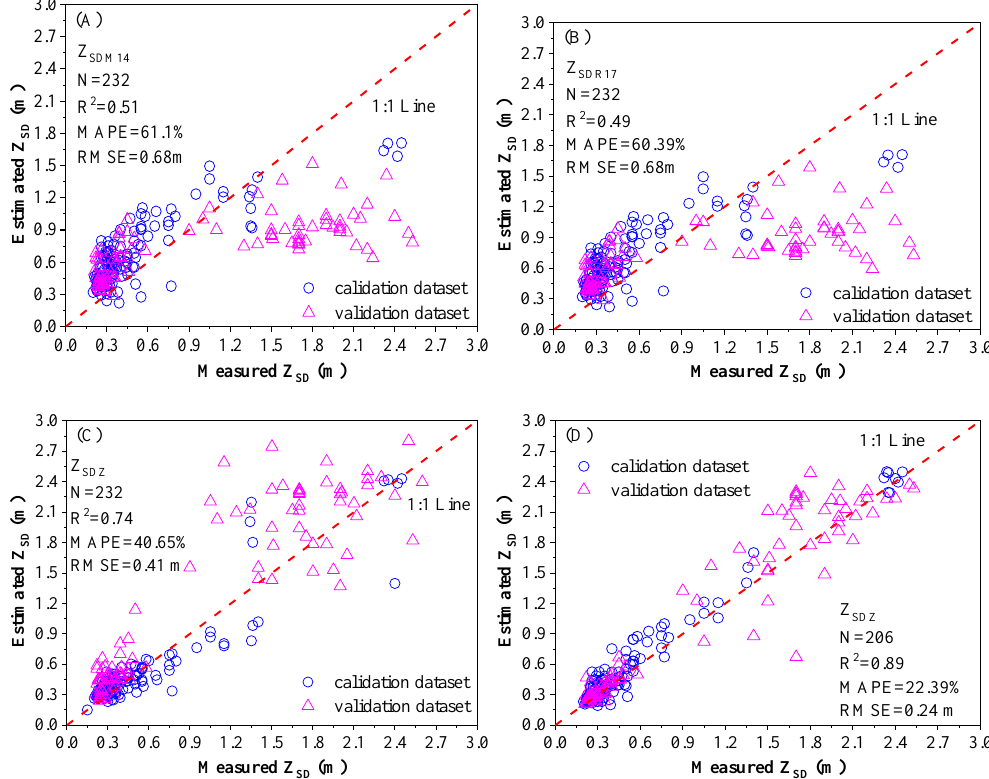
Figure 8. Comparison of the measured and derived Z SD of the four Models. ( A ) Z SDM14 , ( B ) Z SDR17 , and ( C ) Z SDV6 were provided by previous studies, ( D ) Z SDZ is provided by this study.